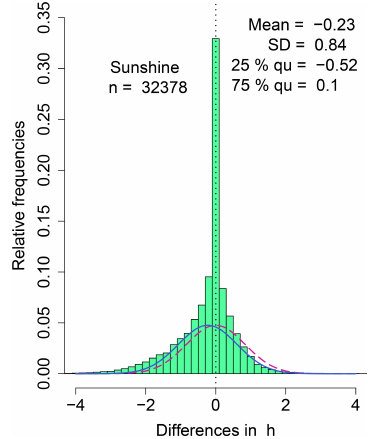
Figure 1. Differences of daily sunshine duration (automatic minus manual observations) in hours. The blue line is the normal distribu- tion using the statistic of the differences; the pink line is a normal distribution with a mean of zero and the standard deviation accord- ing to the statistic of the differences. All data is used.